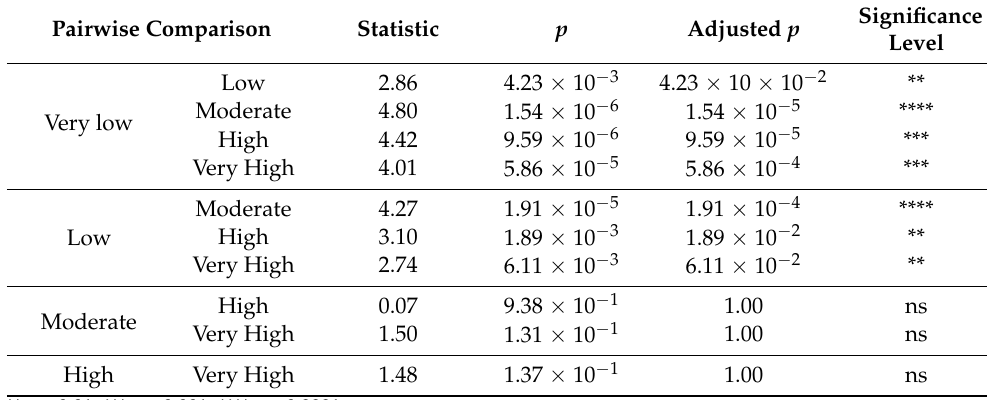
Table A4. Dunn’s test of multiple comparisons using rank sums and Bonferroni p adjustment method.